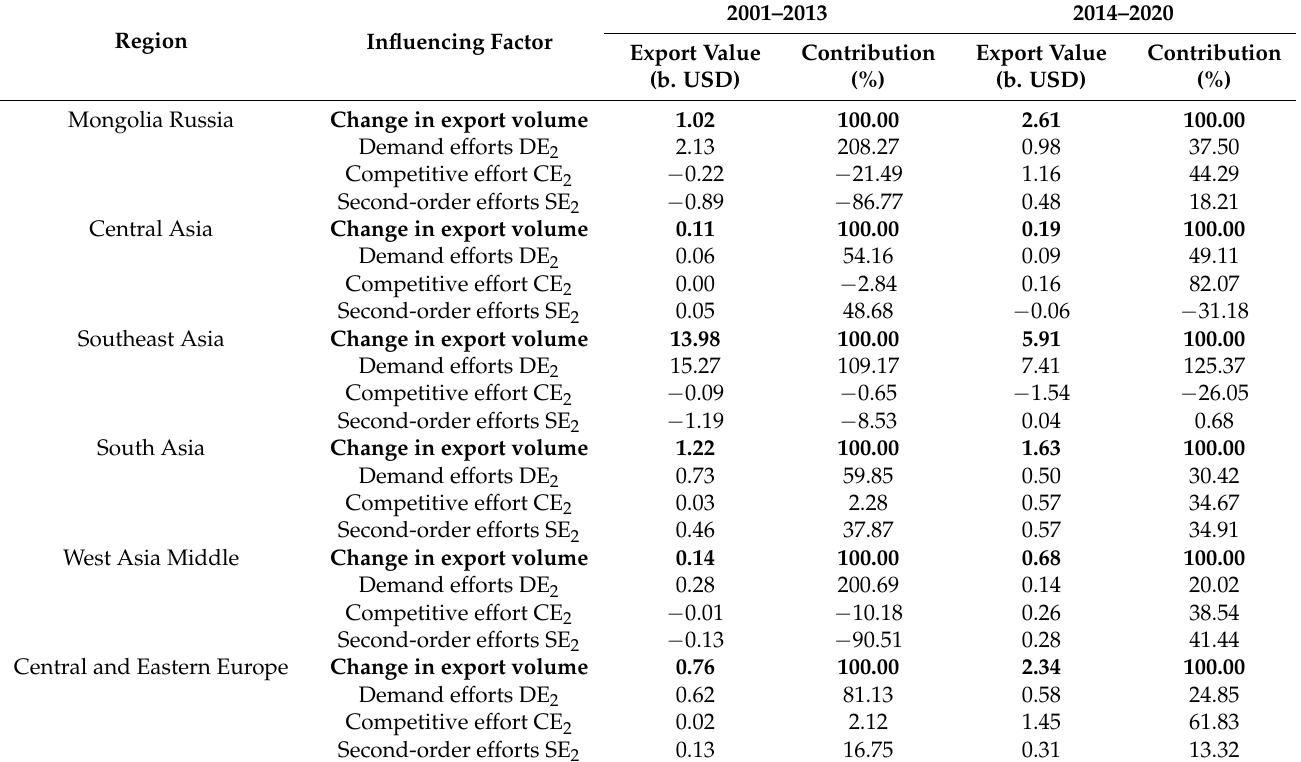
Table 4. Regional distribution of B&R countries exports agricultural to